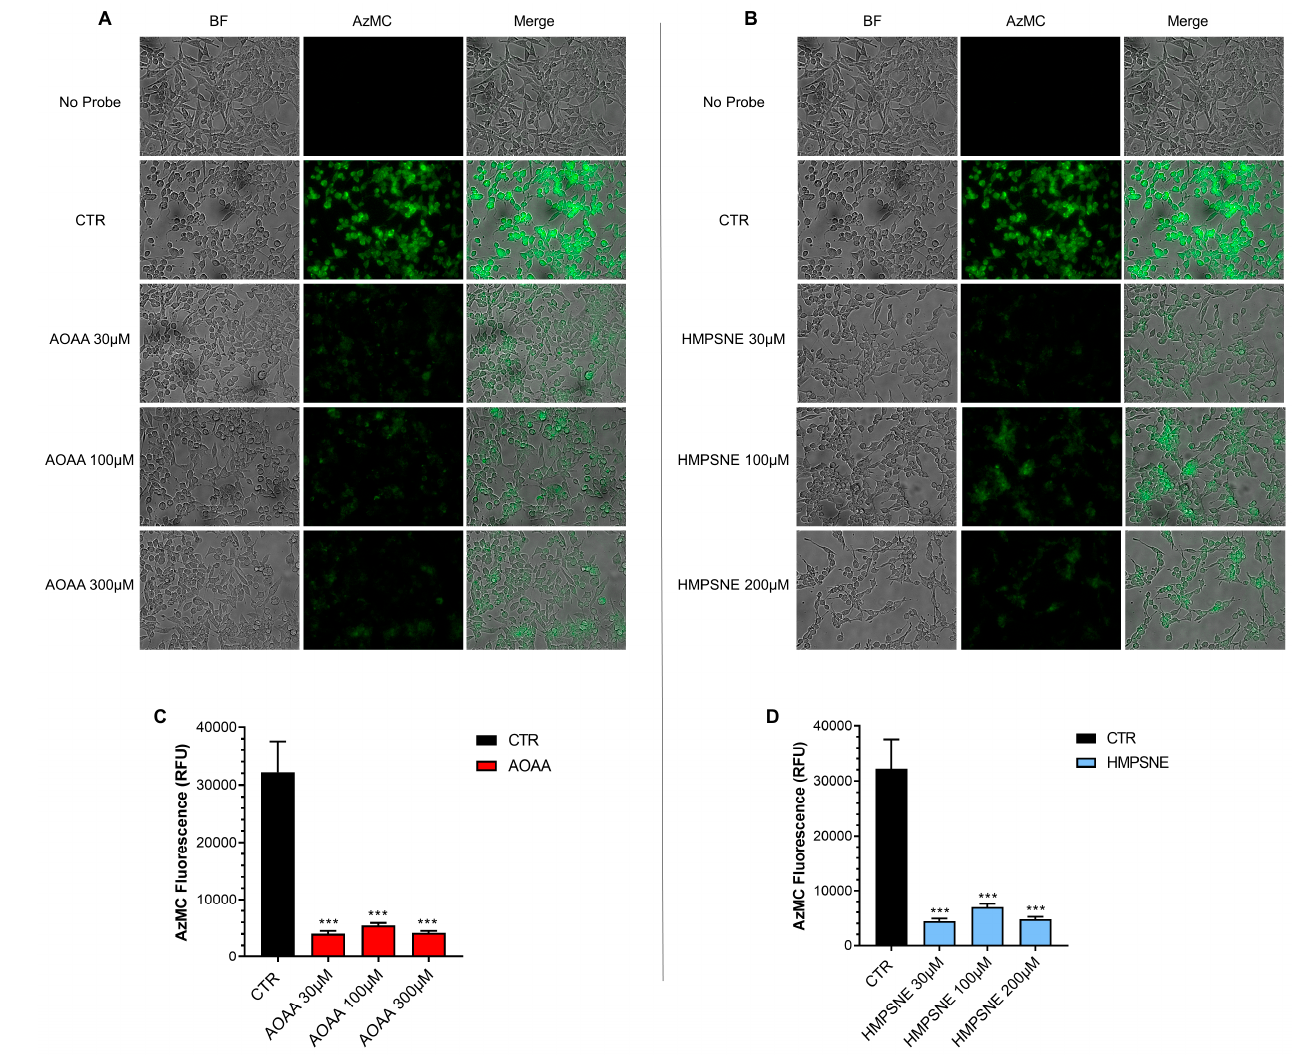
Figure 3. H 2 S synthesis in EO771 cells; effect of CBS/CSE or 3-MST inhibition. The H 2 S-synthesizing capacity of the cells was analyzed by live cell imaging. Incubation with the CBS/CSE inhibitor AOAA ( A , C ) or the 3-MST inhibitor HMPSNE ( B , D ) (24 h treatment of the cells) markedly reduced the H 2 S signal. N = 3 independent experiments ± SEM; *** p < 0.001 shows a significant inhibitory effect of AOAA or HMPSNE on the cellular H 2 S signal.